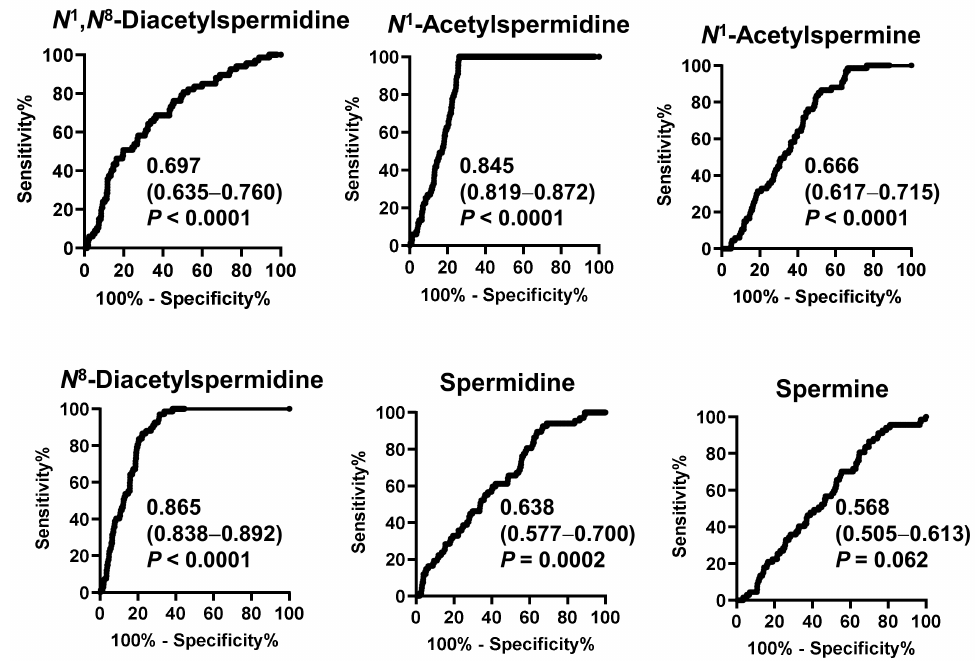
Figure 2. Receiver operating characteristic (ROC) curves to discriminate patients with pancreatic diseases or gallbladder cancer from healthy individuals by salivary polyamines. The area under the ROC curve values, 95% confidential intervals in parenthesis, and p -values are